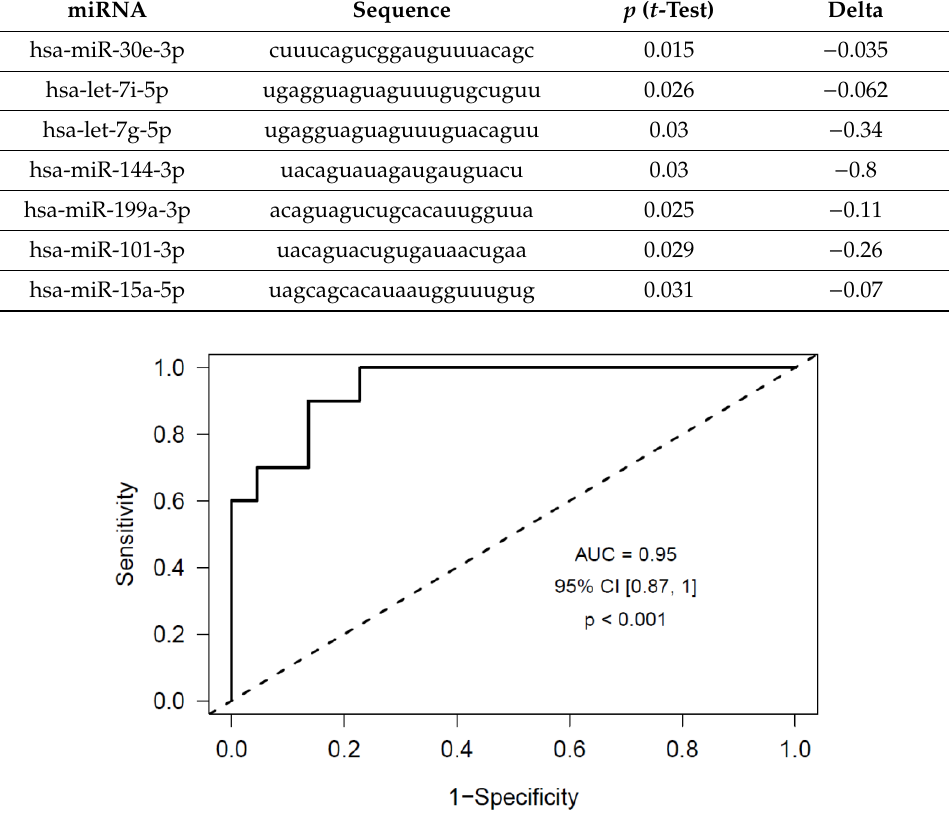
Figure 1. Receiver operator characteristic ROC curve obtained from the confirmation data set using the Elastic Net model that includes 7 miRNAs (miR-486-5p, miR-106b-5p, let-7i-5p, let-7g-5p, miR-144-3p, miR-19a-3p and miR-103a-3p) as risk predictors of future cancer-associated venous thrombosis (VTE) in pancreatic ductal adenocarcinoma (PDAC) and distal extrahepatic cholangiocarcinoma (DECC) patients at diagnosis.